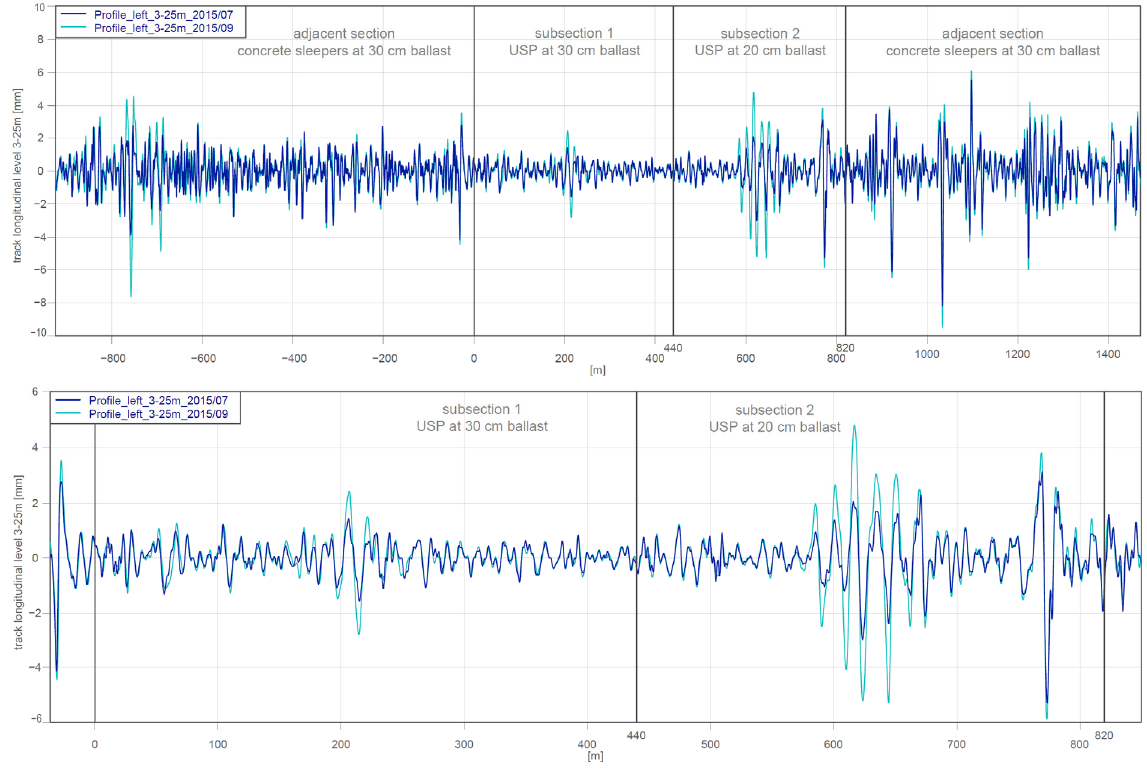
Figure 7. Longitudinal level D1 of two consecutive measurement runs showing the emergence of distinct track geometry defects.